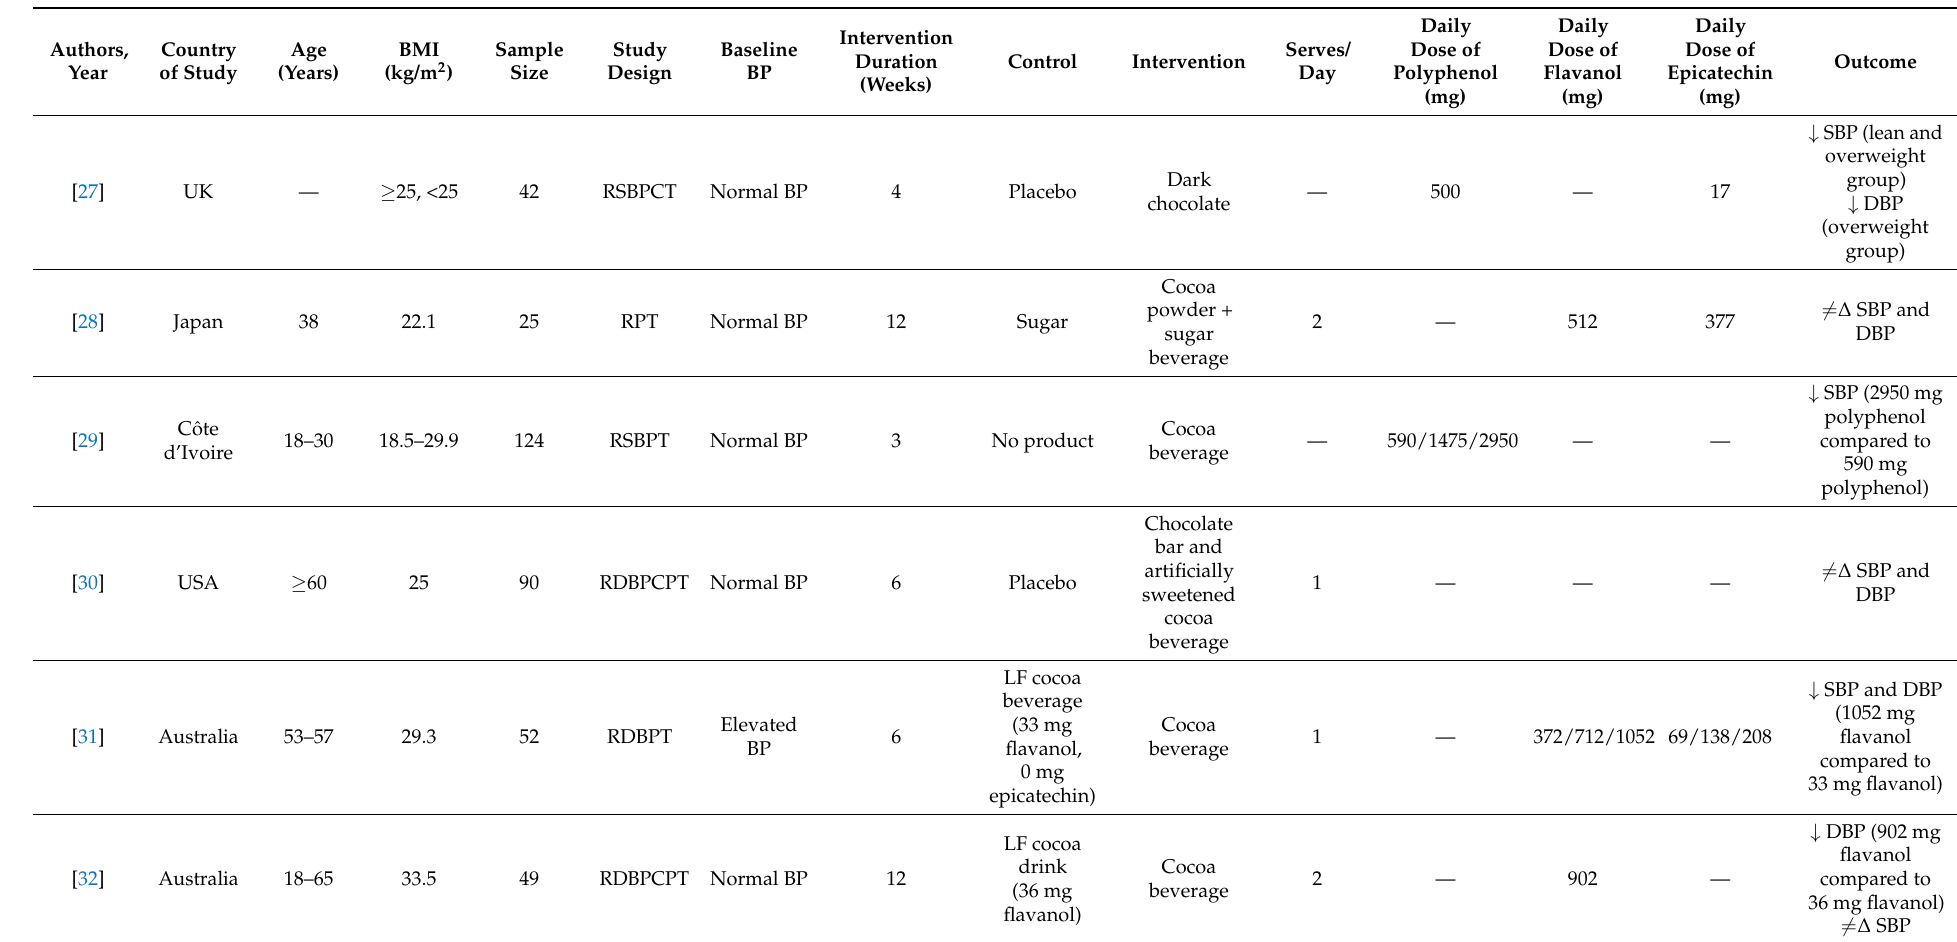
Table 1. Summary of study characteristics and BP outcomes listed in alphabetical order by first author